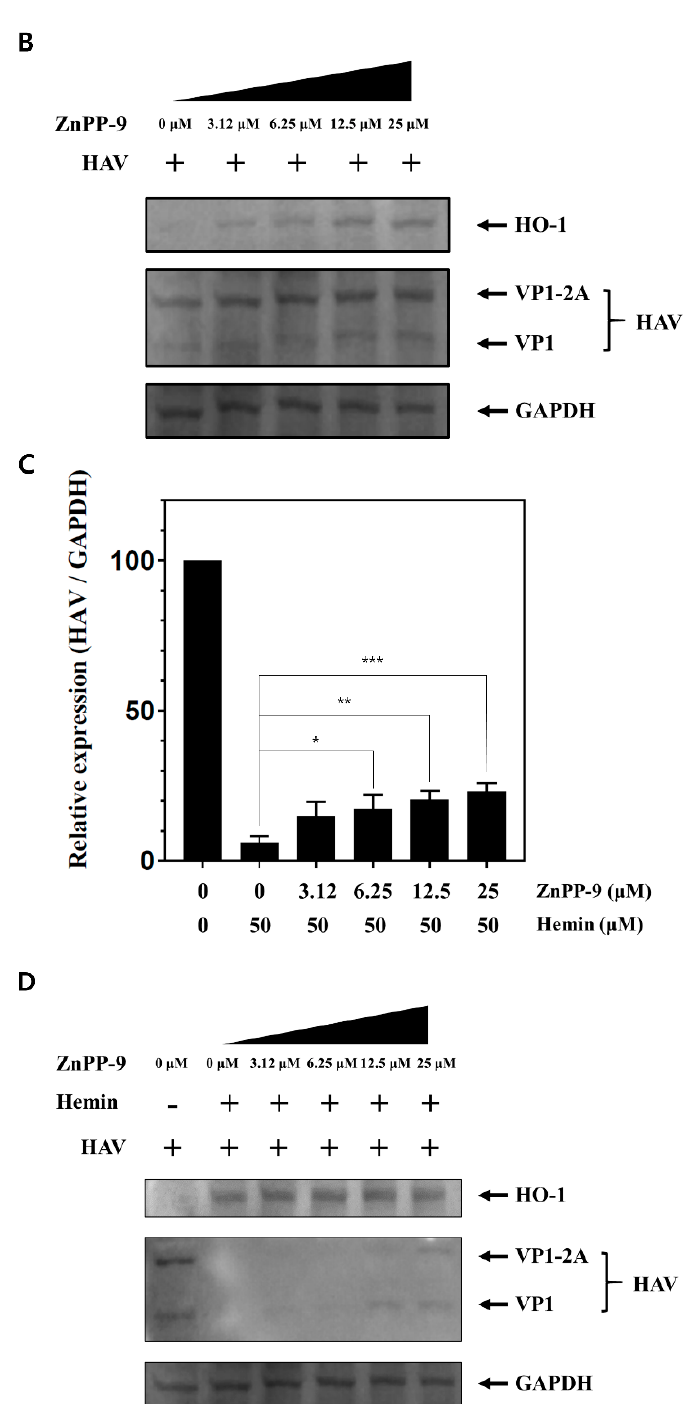
Figure 3. Inhibition of HAV proliferation is due to the enzyme activity of HO-1. ( A , B ) ZnPP-9, which induces HO-1 expression but suppresses enzyme activity, could not suppress HAV proliferation. As the concentration of ZnPP-9 increased, the amount of HO-1 protein increased; however, the amount of HAV did not decrease. ( C , D ) Inhibition of the HO-1 enzymatic activity by ZnPP-9 prevents the inhibition of HAV proliferation by hemin. In the absence of ZnPP-9, the treatment of hemin reduces the amount of HAV proteins; however, combination with ZnPP-99 reversed the inhibitory effect of hemin on HAV expression. Data are presented as the mean ± standard deviations (SD) of at least 3 independent experiments. * p < 0.05; ** p < 0.01; *** p < 0.001.